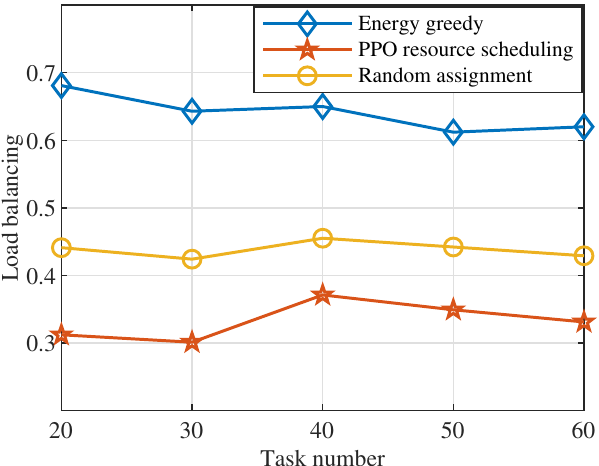
Figure 5. Load balancing with different number of